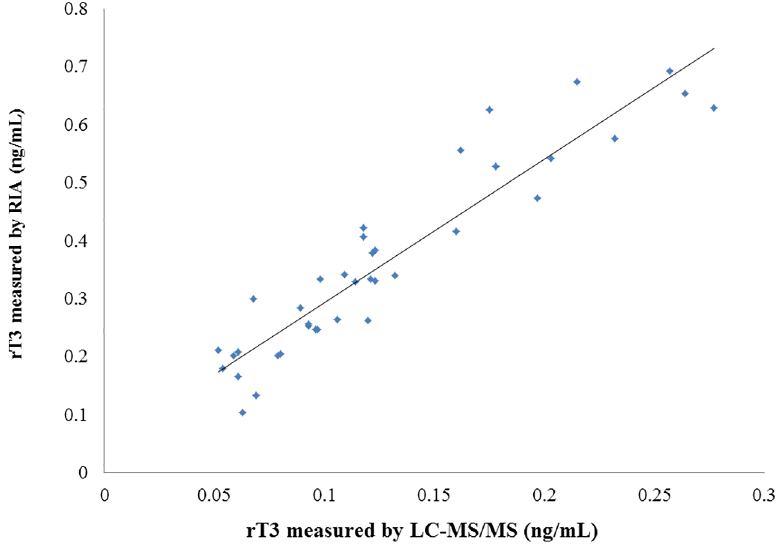
Fig 3. Comparison of the LC/MS/MS method with the RIA method for the measurement of serum rT3. y = 2.48x + 0.0456, r = 0.928, p < 0.001.